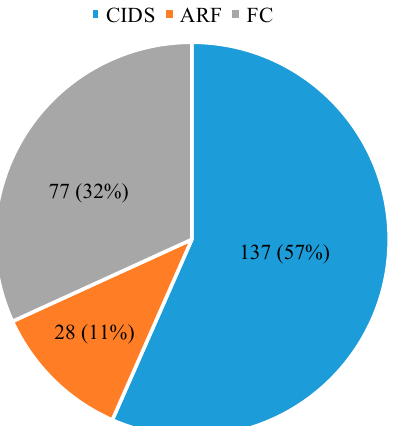
Figure 2. Number of occupied nests of Megachile cephalotes at three different sites from January to